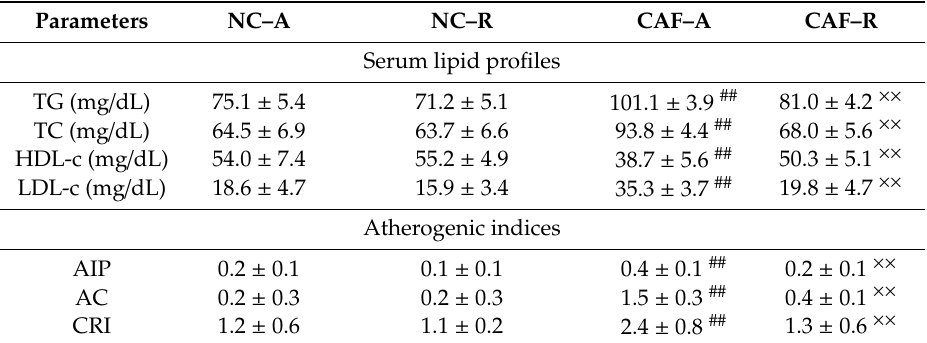
Table 2. E ff ects of time-restricted feeding on serum lipid profiles and atherogenic indices.